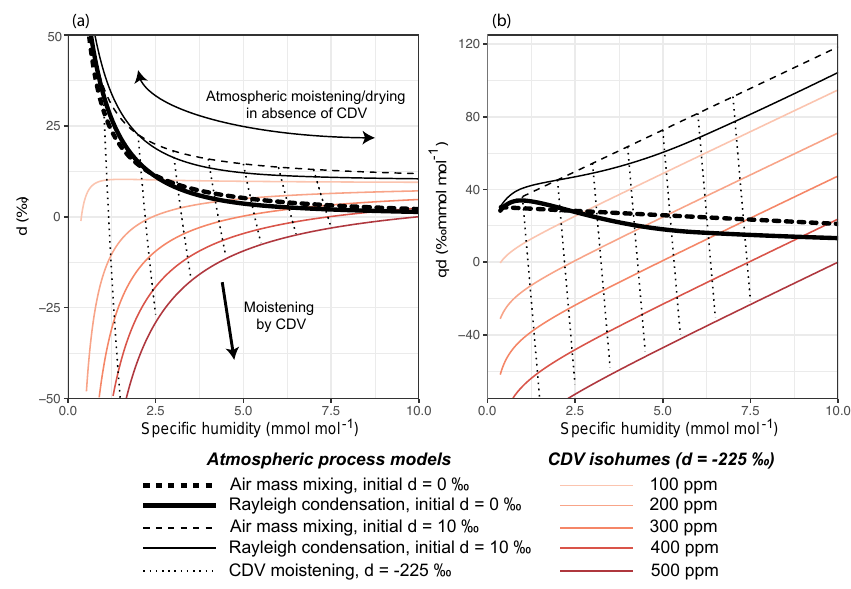
Figure 1. Schematic of expected changes in the d-excess of atmospheric vapor with changes in humidity associated with atmospheric moistening and drying in the absence of CDV due to Rayleigh distillation (solid black lines) or air mass mixing (dashed black lines) or the addition of CDV (dotted black lines). Models for Rayleigh distillation and air mass mixing are shown for two initial d-excess values of the moist end member: 0‰ (thick lines) and 10‰ (thin lines). Panel (a) shows this relationship of d (‰) vs. specific humidity, q (mmolmol − 1 ), where mixing processes trace hyperbolic pathways, and panel (b) shows the same models but with axes of qd (‰mmolmol − 1 ) against q (mmolmol − 1 ), where mixing processes are linear. Finally, lines across a red gradient are drawn to show the impact of fixed amounts of CDV addition ranging from 100ppm (light) to 500ppm (dark) as a function of specific